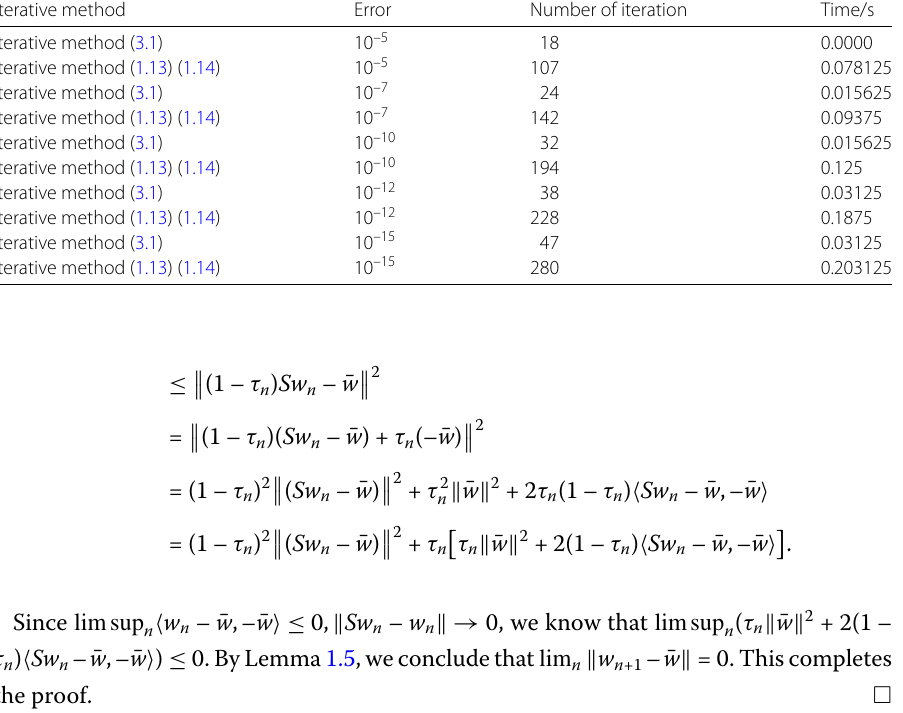
Table 1 Effectiveness of Iterative method Iterative method Error Number of iteration Time/s iterative method